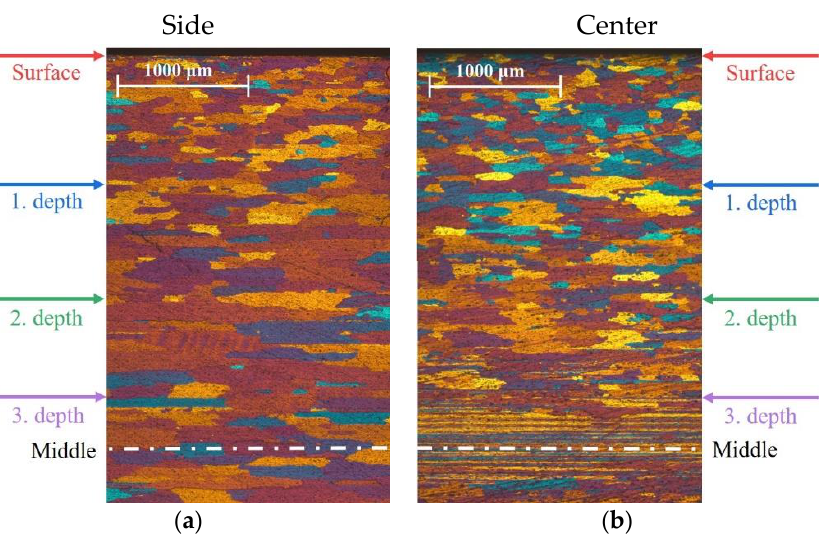
Figure 5. Grain structure on longitudinal sections. ( a ) Sample from the side and ( b ) from the center of the hot-rolled sheet.